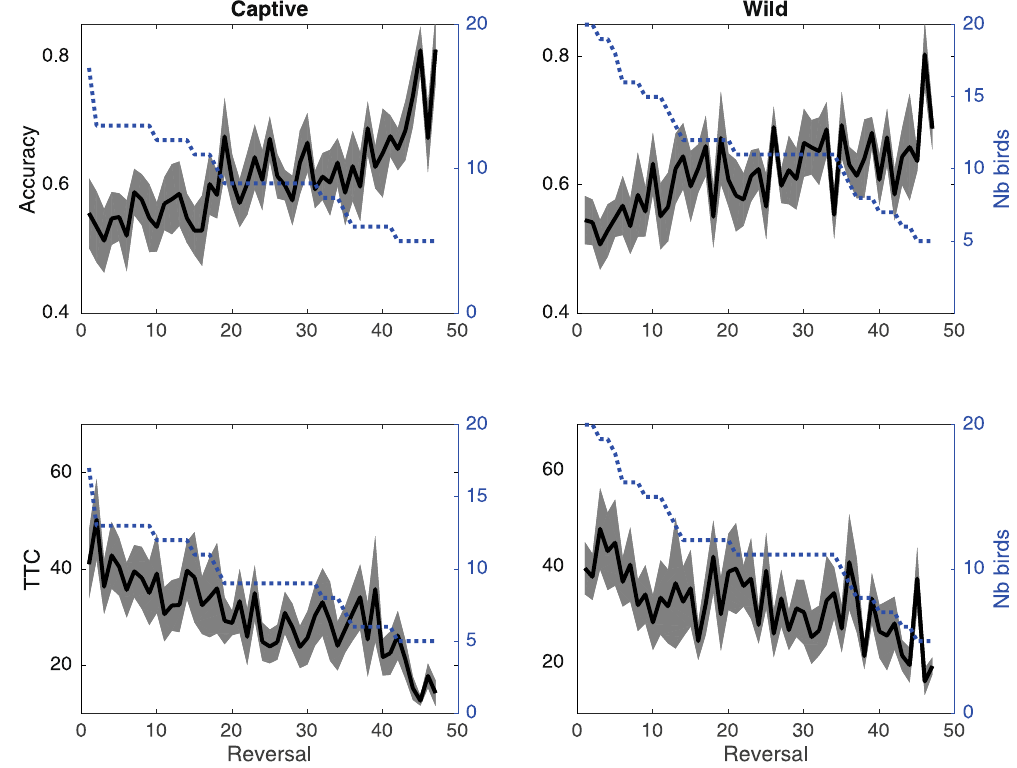
Figure 4. Reversal accuracy and TTC (black line + / − 95% bootstrapped confidence interval in grey) according to successive reversals for captive (left panel) and wild (right panel) birds. The dotted line indicates the number of birds involved in each reversal (right